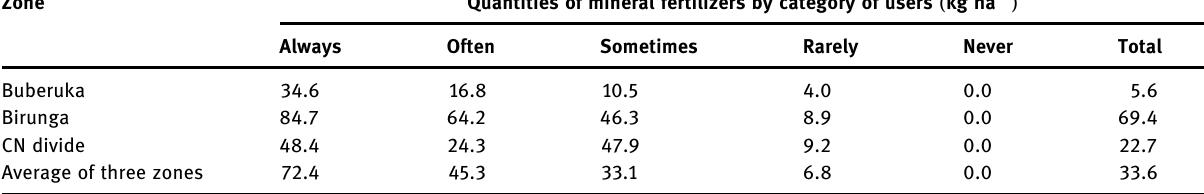
Table 3: Mean values of quantities ( kg per hectare ) of mineral fertilizers by categories of users Zone